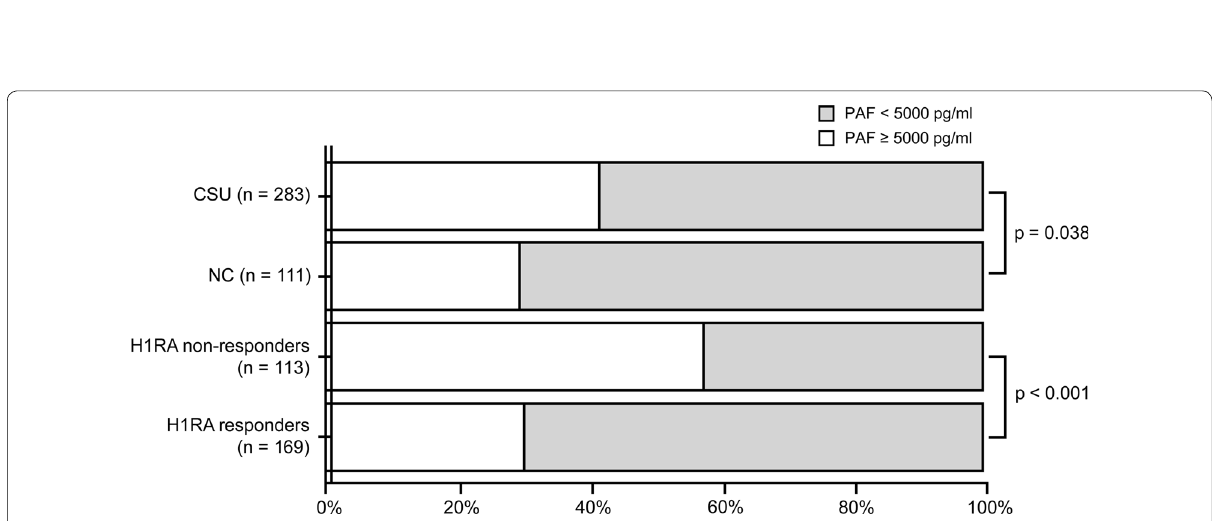
Fig. 3 Prevalence of subjects with high PAF ( 5000 pg/ml) and low PAF (< 5000 pg/mL) in CSU patients versus NCs and H1RA responder versus ≥ non‑responders. PAF platelet activating factor, CSU chronic spontaneous urticaria, NC healthy normal control, H1RA histamine receptor 1 antagonist